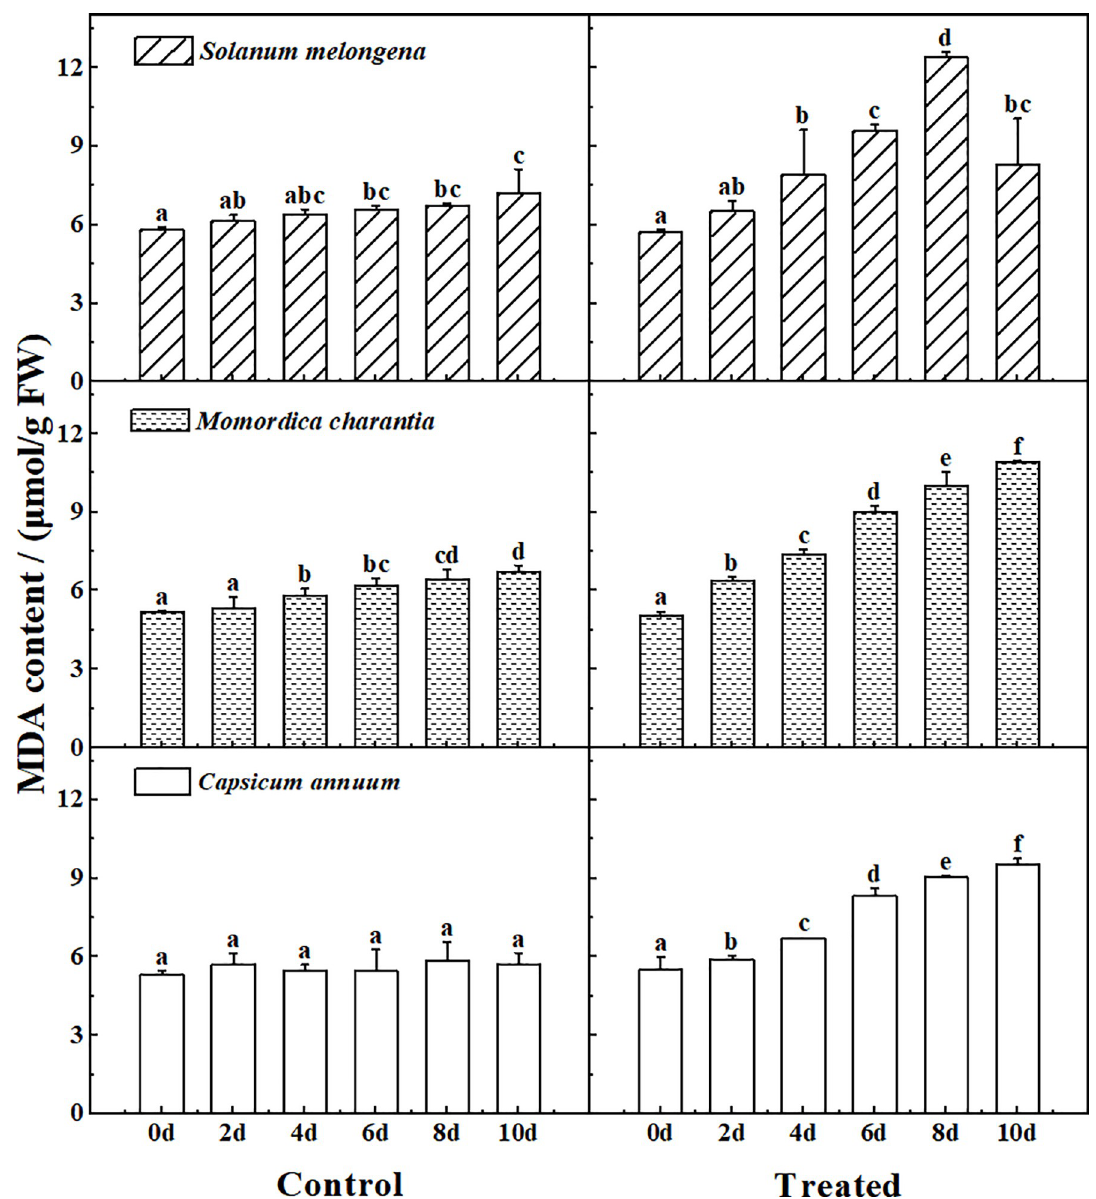
Fig 4. The response of malondialdehyde (MDA) to normal watering (Control) and salt water irrigation (Treated) in Solanum melongena , Momordica charantia , Capsicum annuum . The single salt solution (NaCl, 150 mmol/L) was watered once a day (25 ml per pot) for a total of 10 days, seedling leaves were randomly sampled every 2 days to determine MDA. Error bars represent standard errors of MDA with 4–5 replicates measurements. The same letter in each picture represents no significant difference (Duncan test, P < 0.05, n = 4–5). under this condition. After 10 days of salt stress treatment for the three cash crops, the soil salt contents are higher than 3 g/kg. Among them, the soil salt content for Momordica charantia , Capsicum annuum are grade III, and for cultivating Solanum melongena reached 3.97 g/kg (Salinity Grade IV). It can be seen from the measurement results that the soil salt content of the control group also decreased after 10 days, but it was not significant. At the end of the stress treatment, the soil salinity of the three cash crops in the treatd group increased sharply,